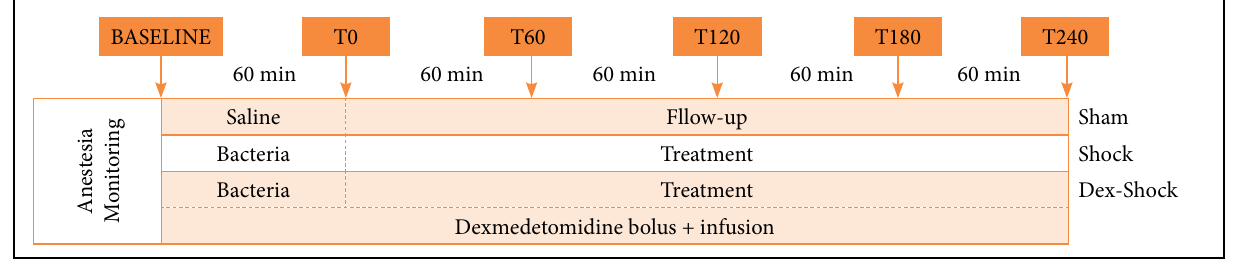
Figure 1 - Experimental